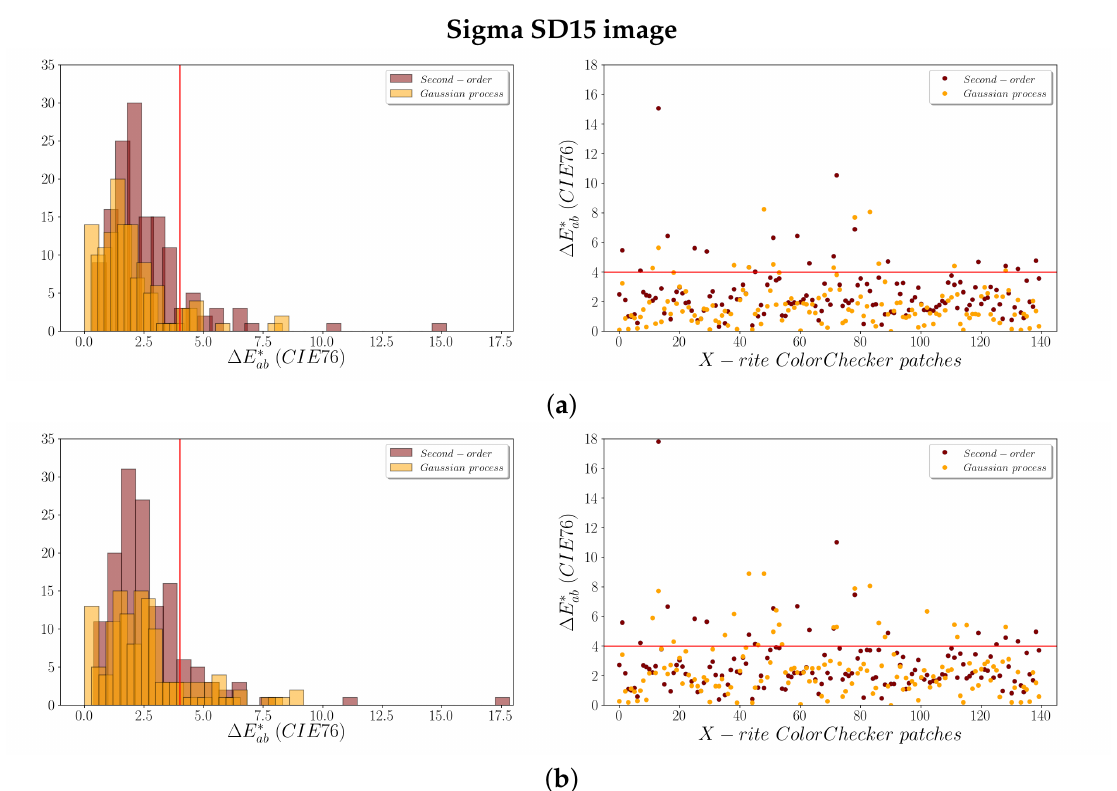
Figure 4. Sigma SD15 ∆ E ∗